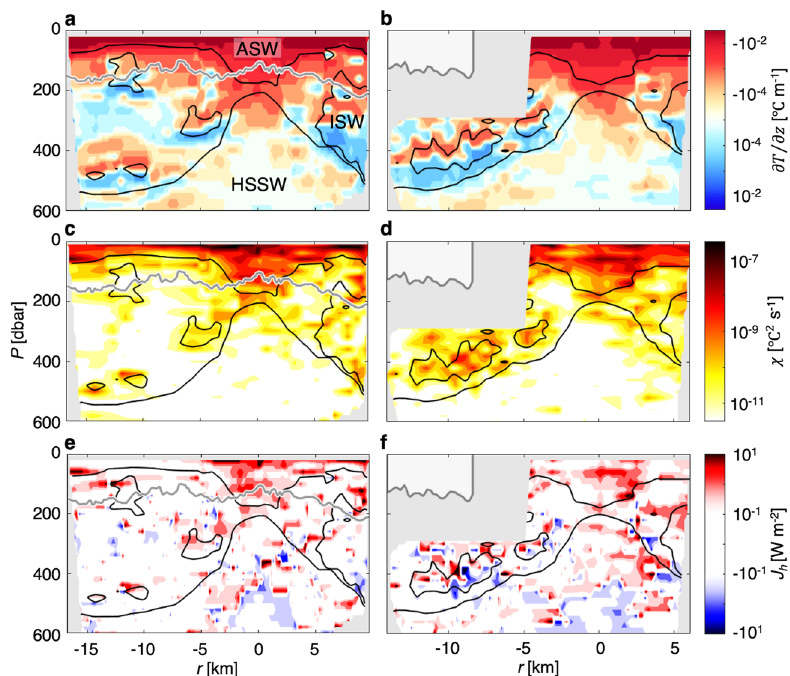
Fig. 8 Eddy heat transport. a , b Vertical temperature gradient, where negative values (red) indicate decreasing temperature with increasing depth. c , d Rate of temperature variance dissipation. e , f Vertical heat fl ux, where red indicates downward heat transfer. a , c , and e are interpolated from the glider transect parallel to the NIS calving front (red lines in Fig. 1b), where grey lines indicate the nearby ice draft. b , d , and f are interpolated from the glider transect perpendicular to the NIS calving front (blue lines in Fig. 1b), where light grey polygons show the nearby ice draft. Black lines show the extent of ASW, ISW, and HSSW (de fi ned in Figs. 4 and 5) and the grey background signi fi es regions of no data. Similar diagrams of heat transport during eddy formation are provided in Supplementary Fig.